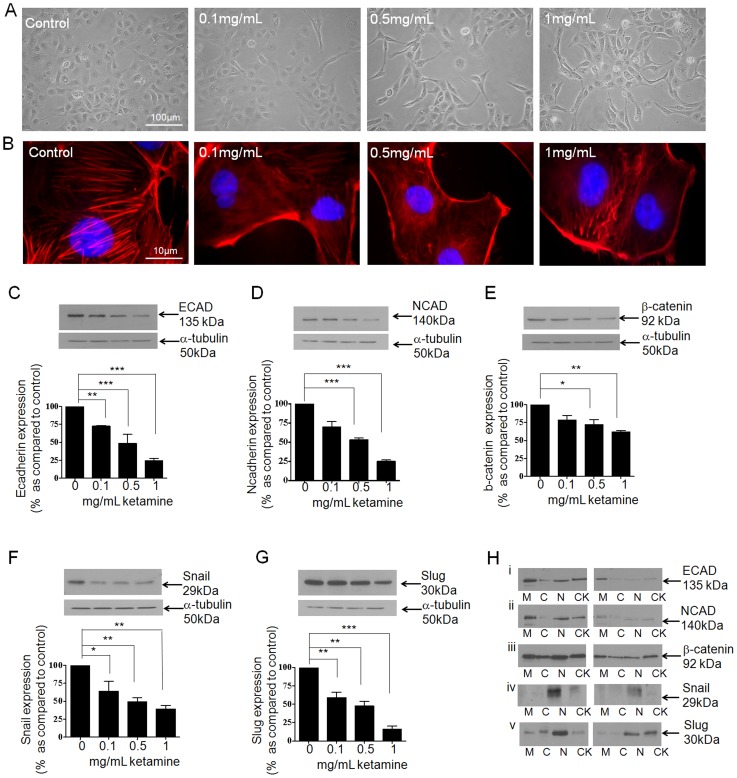
Ketamine evoked changes in AJ-protein expression in HK2-cells.To assess the effect of Ketamine on expression of key AJ proteins, HK2 cells were cultured in 5 mM glucose containing media for 48 hrs prior to overnight serum starvation. Cells were stimulated for 24 hrs with Ketamine (0.1–1 mg/mL) under serum-free conditions and morphological and phenotypic changes assessed. Phase contrast microscopy (panel A) and TRITC conjugated phalloidin (panel B) confirmed the dose dependent effects of Ketamine on cell morphology and cytoskeletal reorganization respectively. Whole cell expression of E-cadherin and its transcriptional co-repressor Snail were determined by western blotting. Ketamine decreased expression of E-cadherin (panel C) Snail (panel F) and Slug (panel G). Compartmental localisation of E-cadherin, Snail and Slug expression were determined for membrane (M), cytosol (C), nuclear (N) and cytoskeletal (CK) fractions +/− Ketamine (1 mg/mL). Ketamine altered the cellular localization of all three proteins, compared to control (panels Hi, Hiv and Hv respectively). Ketamine also down-regulated expression of N-cadherin (panel D) and β-catenin (panel E), with a loss in expression being apparent throughout the cell (panel Hii and Hiii respectively). Upper panels show representative blots for each protein and re-probed for α-tubulin as a loading control. Lower panels show mean (±SEM) densitometry data, normalised against the non-stimulated low glucose control (100%), from 3 or more separate experiments. Each lane in the representative blot corresponds to the associated bar in the graph. Key significances are shown, *P<0.05, *P<0.01, ***P<0.001.